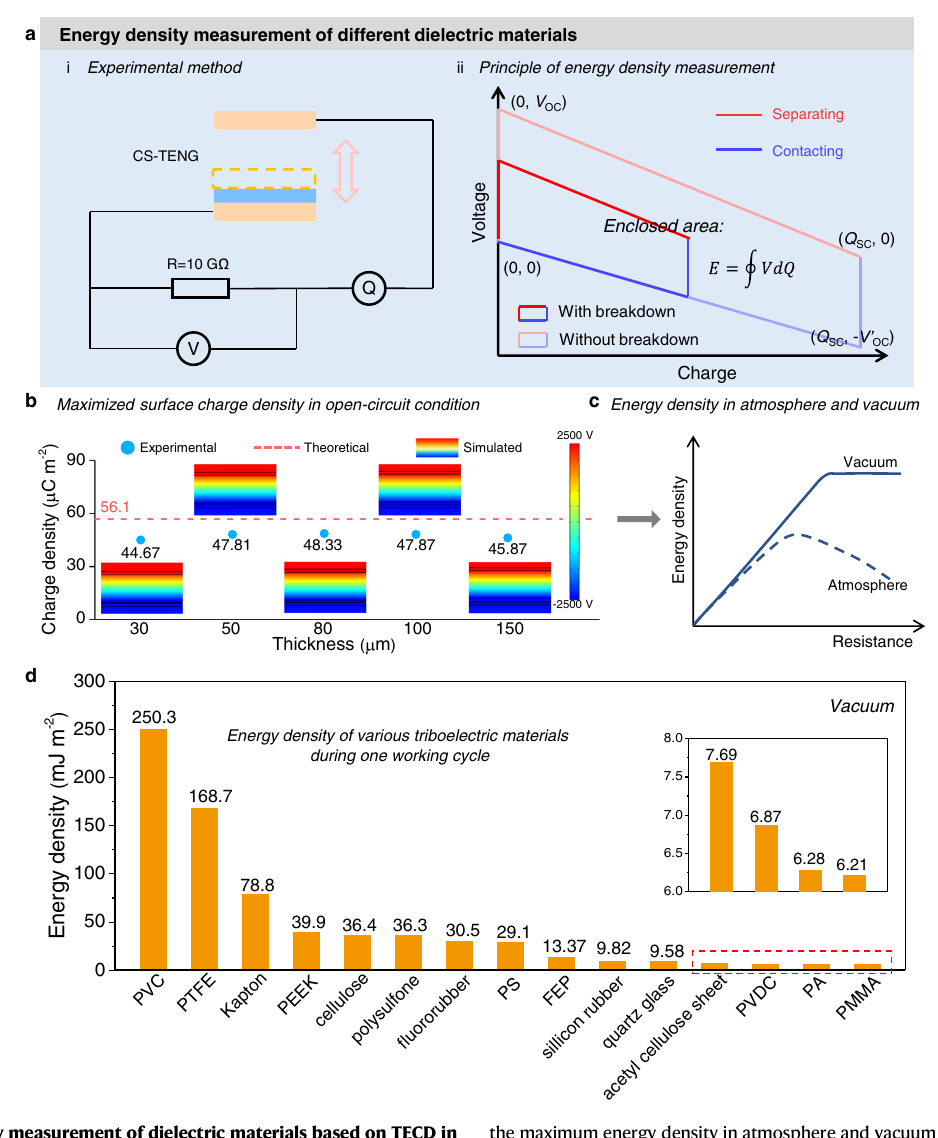
the maximum energy density in atmosphere and vacuum condition. d Quanti fi ed maximumenergydensityof fi fteenrepresentedmaterialsduringoneworkingcycle in CS-TENG. Source data are provided as a Source data fi